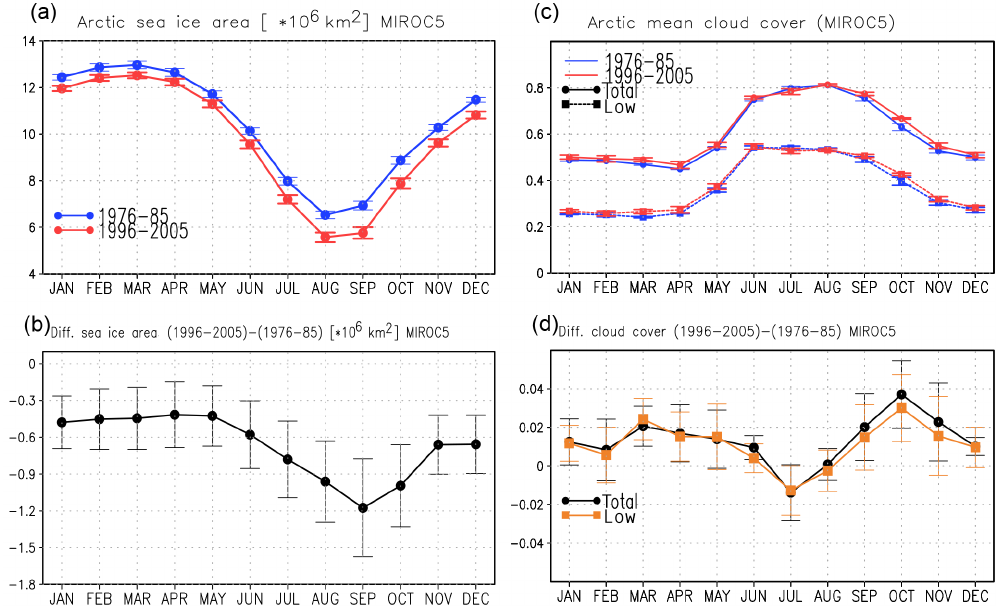
Figure 2. Seasonal cycle of (a) Arctic mean sea ice area averaged over the periods 1976–1985 and 1996–2005 in MIROC5 and (b) the difference between the means; (c) and (d) are identical to (a) and (b) except for the total and low cloud covers. The unit of sea ice area is 10 6 km 2 . in cloud cover expanded broadly over the Arctic